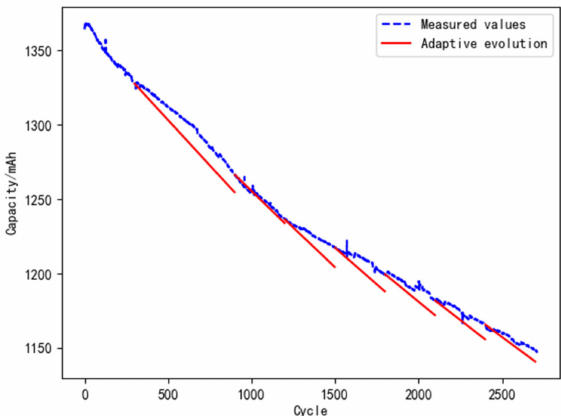
Figure 13. Model evolution with adaptive cycles.